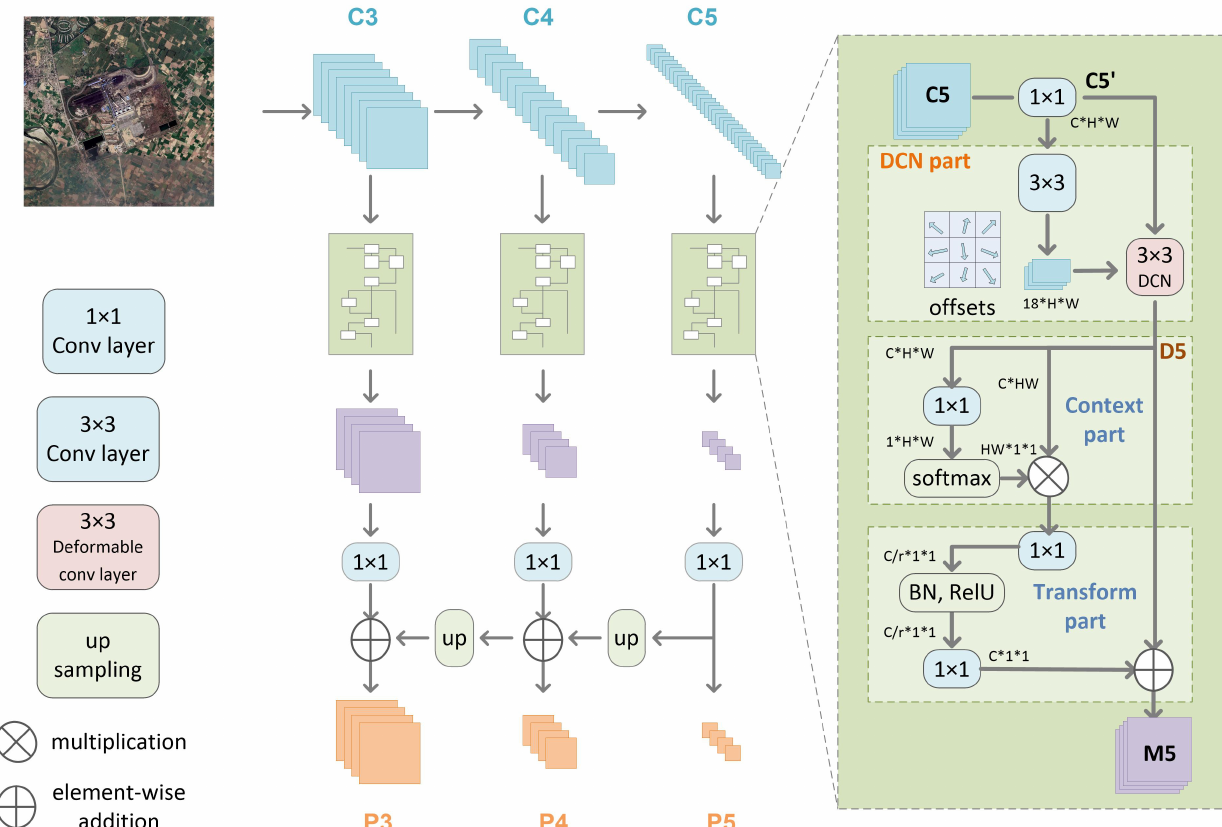
Figure 5. Architecture of our CMN. Based on FPN [14], CMN is constructed by two modules including deformable convolution and context module (context attention and a